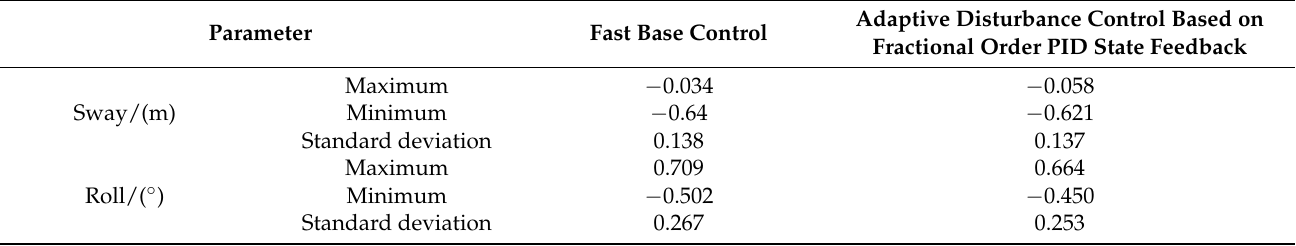
Table 5. Comparison of sway displacement and roll angle under two control